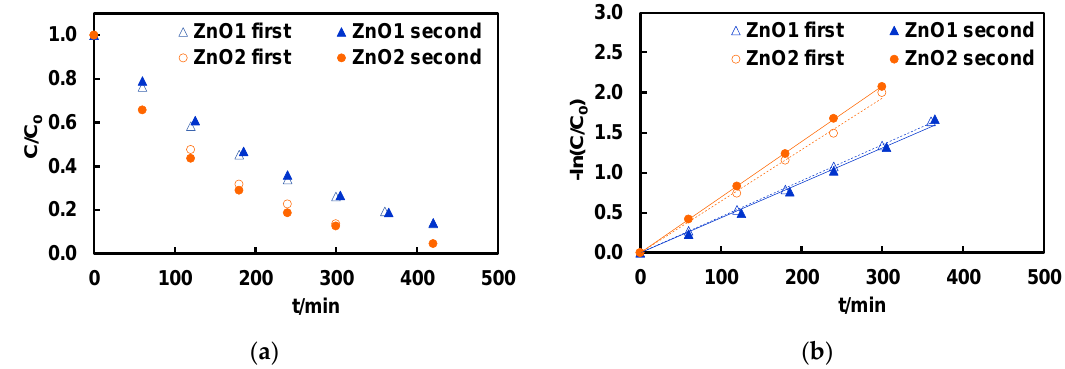
Figure 5. ( a ) RhB concentration profiles during photocatalytic runs in the presence of 0.1 g L −1 of ZnO1 (triangles) and ZnO2 (circles) under irradiation with a 420 nm cut-off filter; ( b ) corresponding kinetic data elaboration according to a first – order rate law.